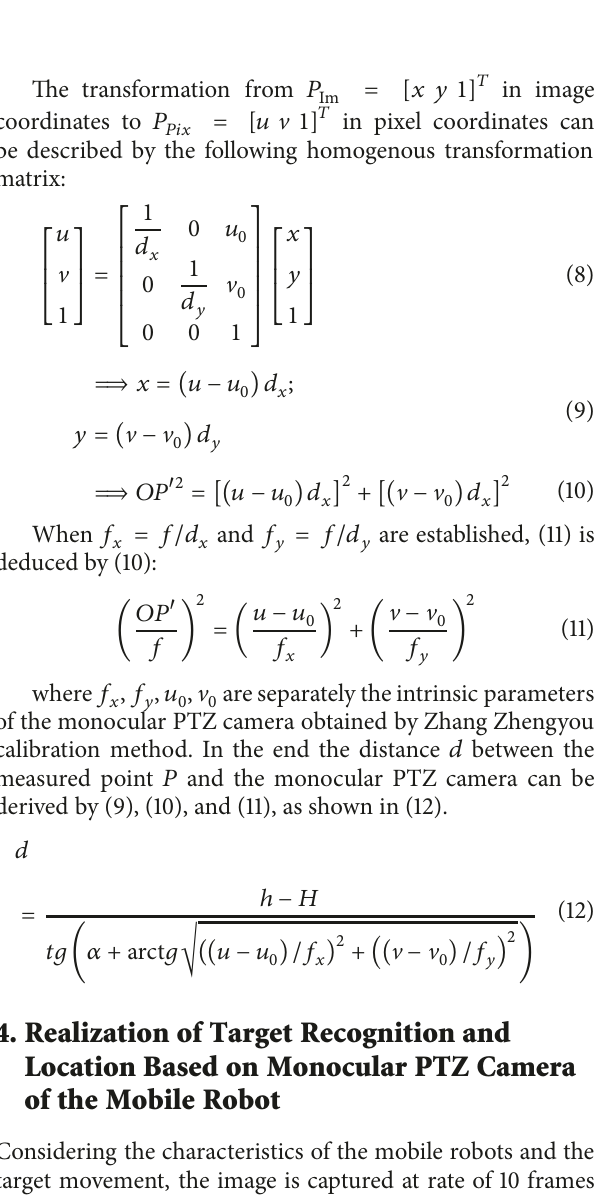
Figure 11: (a) Original photo, (b) effect diagram of Canny edge detection, and (c) effect diagram of Hough transform for circle detection.